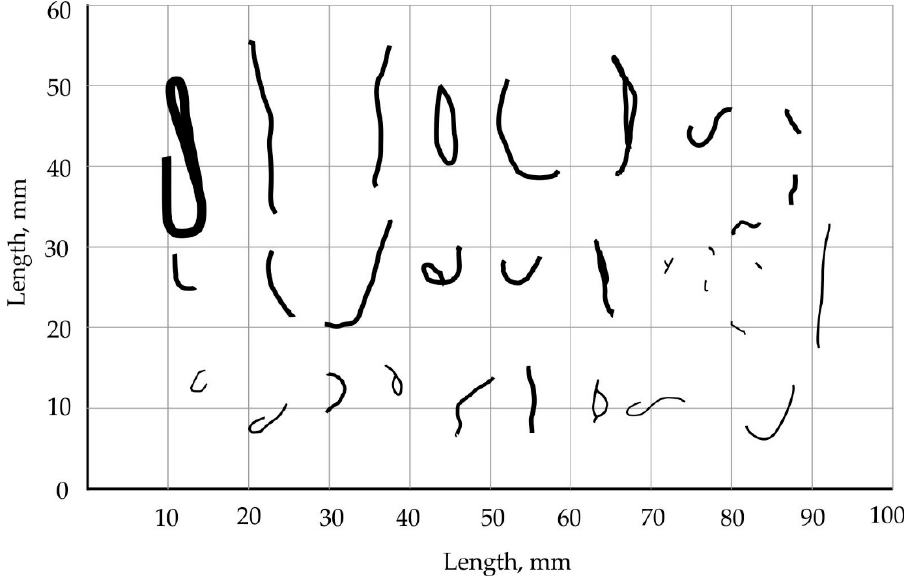
Figure 1. Varieties of non-fibrous inclusions.